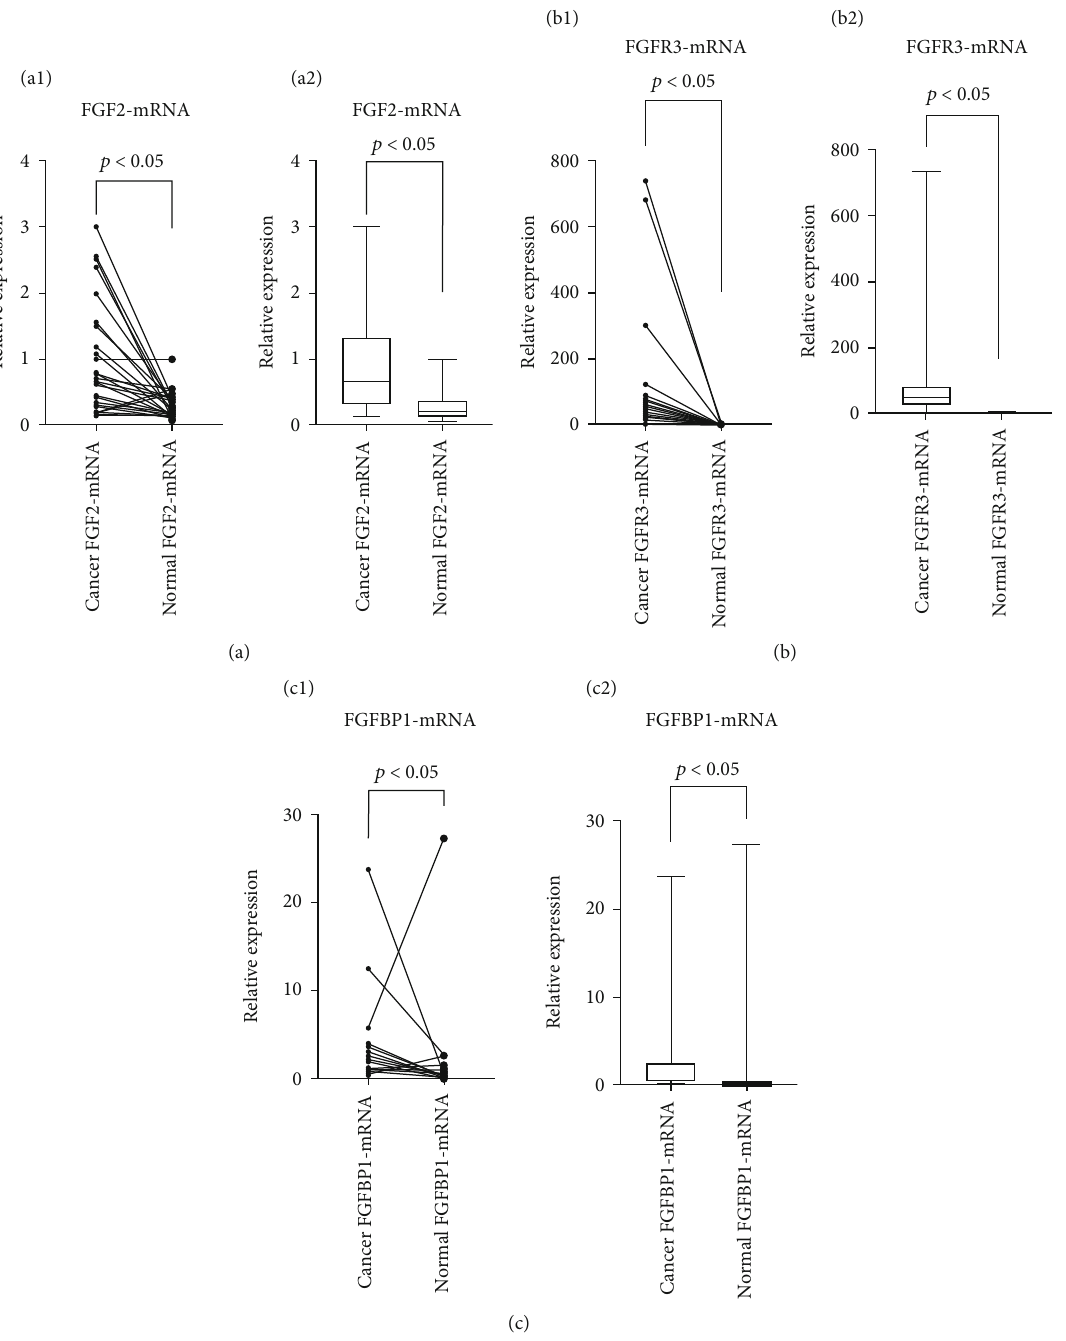
Figure 2: The expression of FGF2, FGFR3, and FGFBP1-mRNA in cancer tissues was signi fi cantly higher than that in adjacent tissues ( p < 0 : 05